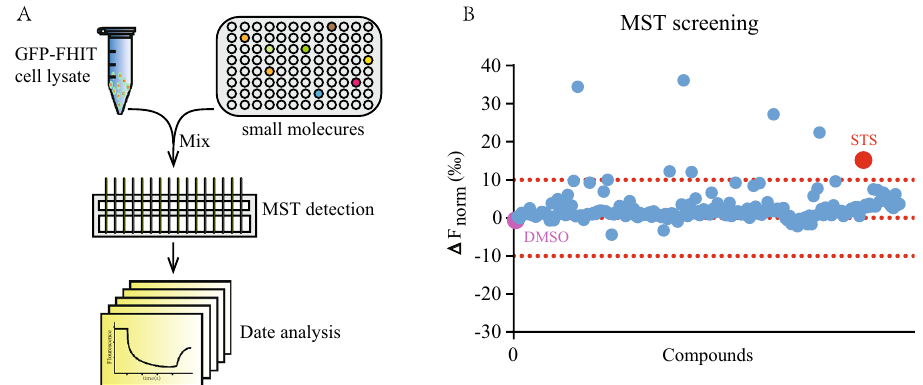
Figure 1. MST screening of small molecules binding FHIT. ( A ) Schematic overview of MST based single-point screening. ( B ) Plotting of single-point MST screening of a library of FDA products towards